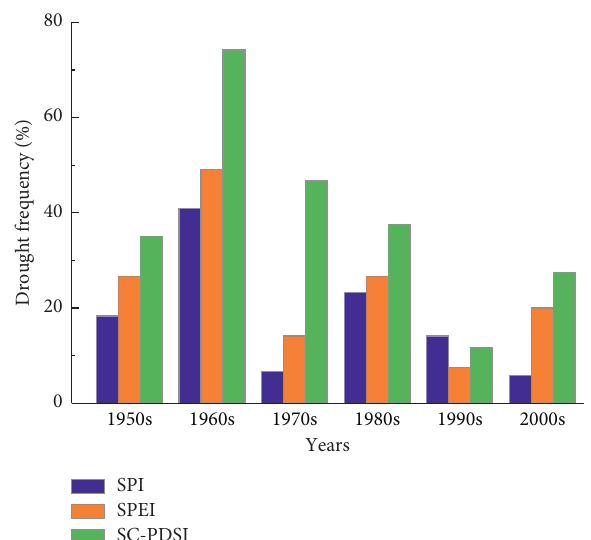
Figure 3: Interdecadal variations in the drought frequency in the